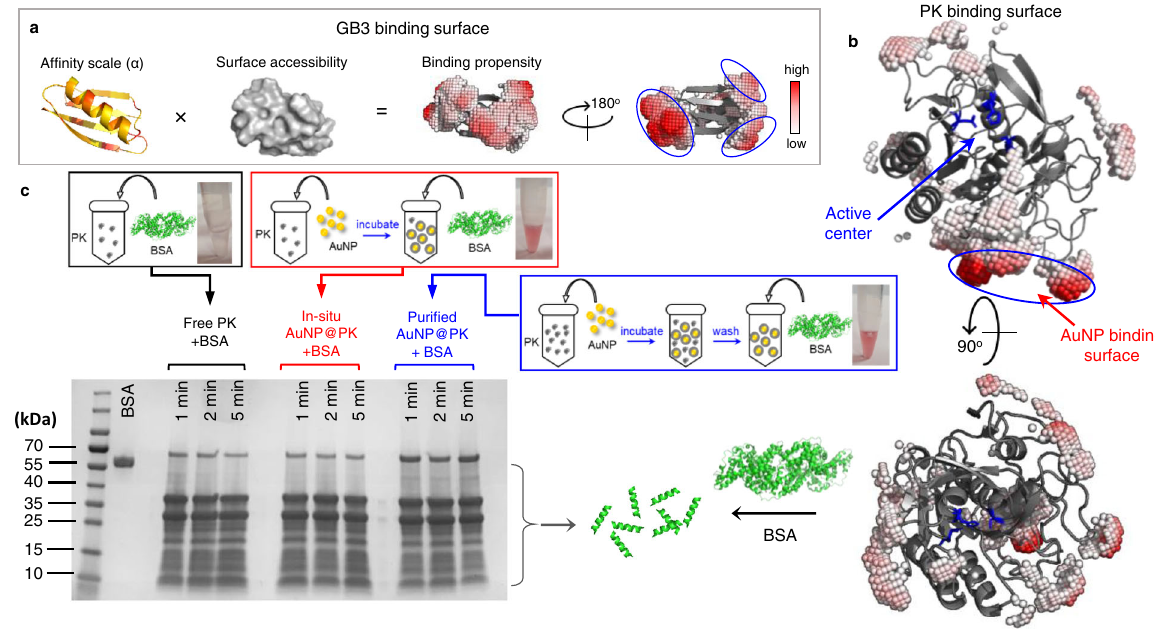
Fig. 4 | Prediction of bound orientation of Proteinase K (PK) on AuNP. a A scheme for deducing the preferredbound surface ofGB3 by taking both the alpha value and surface accessibility into account (see main text). Alpha values in the leftmostimagearedepictedusingayellow(low)tored(high)gradient.The α -helix sideand β